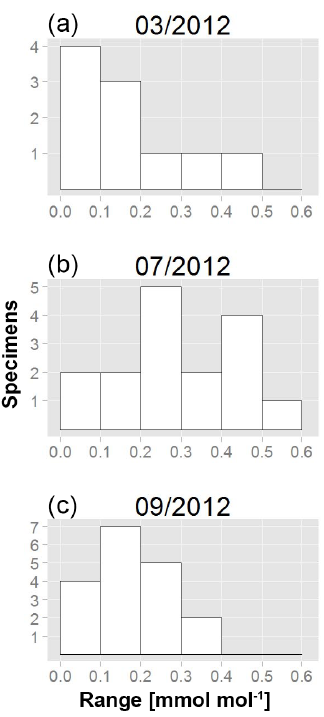
Figure 4. Histograms representing Mn / Ca intra-test variability as a range (difference between maximum and minimum Mn / Ca per specimen of A. tepida ). (a) March, 10 specimens; (b) July, 16 spec- imens; (c) September, 18